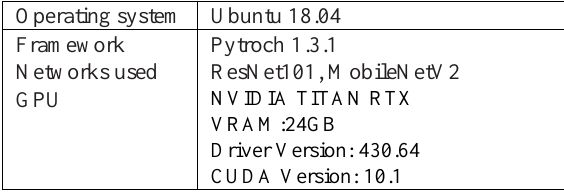
Table 4. Experimental setup used in the study